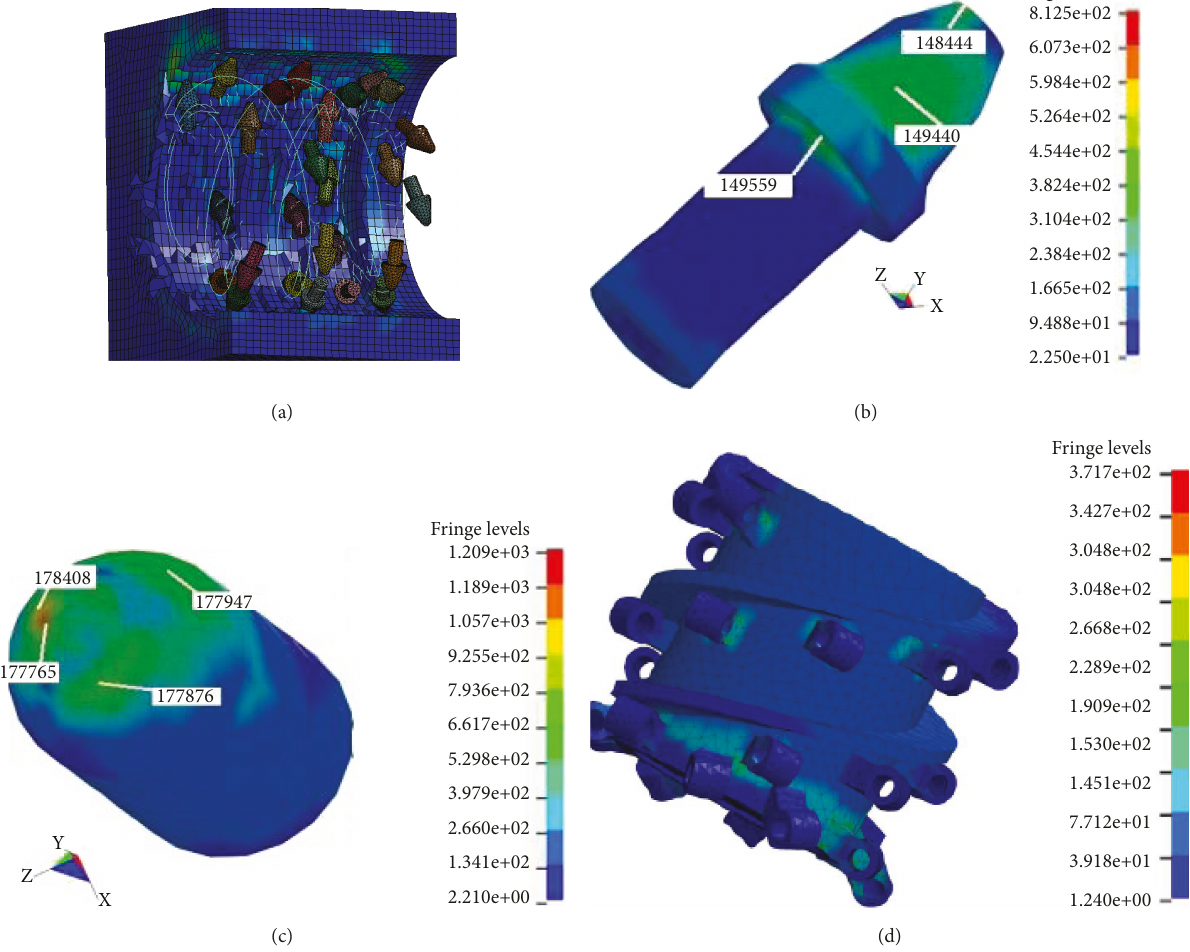
Figure 11: Stress cloud diagram of the drum and